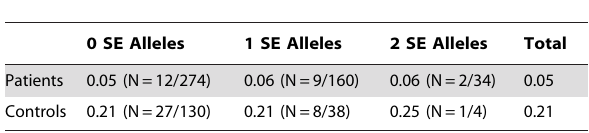
Table 4. Minor allele frequency (MAF) of rs231778 segregated by HLA-DRB1 shared epitope status.